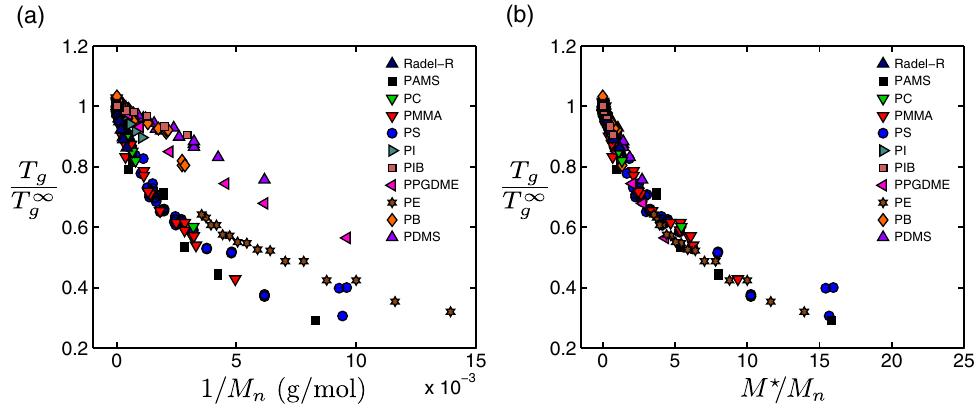
=T ∞ vs 1 =M and (b) T g g